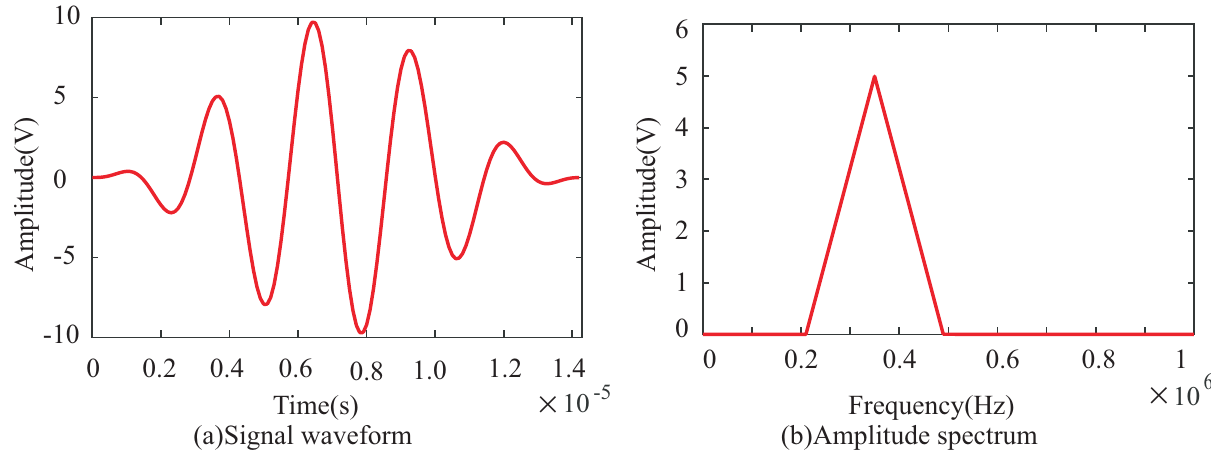
Figure 4. Narrow-band excitation signal with a central frequency of 350 kHz. Taking the lower left corner of the specimen as the coordinate origin, the coordinates of those transducers are (300,300), (200,200), (400,200), (400, 400) and (200, 400), respectively. These PZT transducers are selected by the D33 instrument and WK6500B low-frequency impedance analyzer, and their properties are almost the same. The diameter of these PZT transducers is 10 mm and the thickness is 0.5 mm. The properties are shown in Table 1. A 6 mm diameter hole damage is prefabricated. Generally, the PZT transducer array divides the specimen into three regions: A, B and C. The three regions are represented by green, yellow and blue, respectively. A schematic diagram is shown in Figure